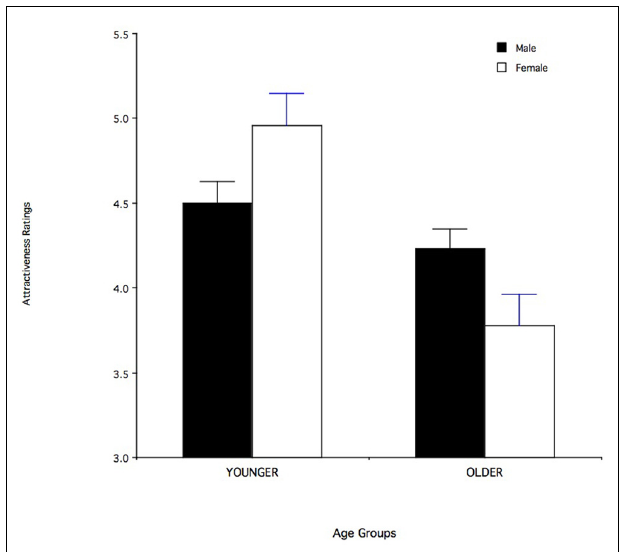
FIGURE 1 | Mean ( + SEM) ratings of facial attractiveness for male and female face stimuli in the younger (35–50 years) and older (51–65 years) age groups. Data for male respondents only.